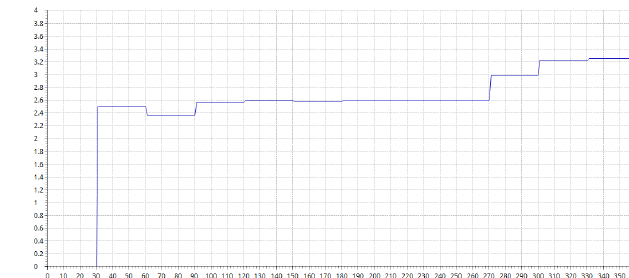
Figure 17. Service Level of Scenario I.